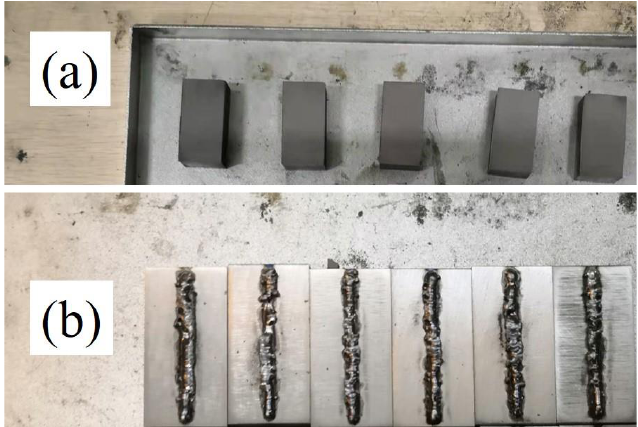
Figure 3. ( a ) Macro view of the uncoated samples; ( b ) macro view of the coated samples. Afterward, the morphology of the coating was observed by the ZEISS Axio Plan2 Optical Microscope (OM) (Zeiss, Shanghai, China), and the image-Pro plus software was used to measure the height (H), width (W), and dilution rate (D = A 2 /A 1 + A 2 ) (Figure 4a,b), where CZ stands for coating zone, MZ denotes melted zone, HAZ represents heat-affected zone, and SZ is substrate. The geometric characteristics of the 27 obtained samples are shown in Table